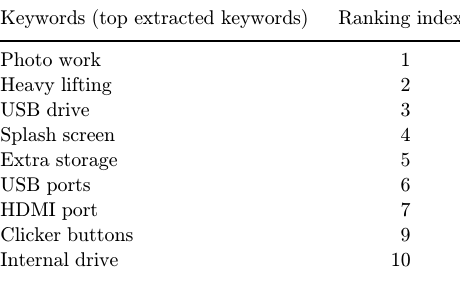
Table 7. Extracted keywords from the top positive reviews for laptops. Keywords (top extracted keywords)